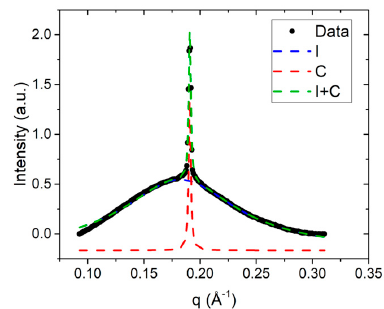
Figure 5. SAXS peak for DSCG 0.34 mol/kg + PEG 0.011 mol/kg mixture, fit to a sum of two Lorentzian